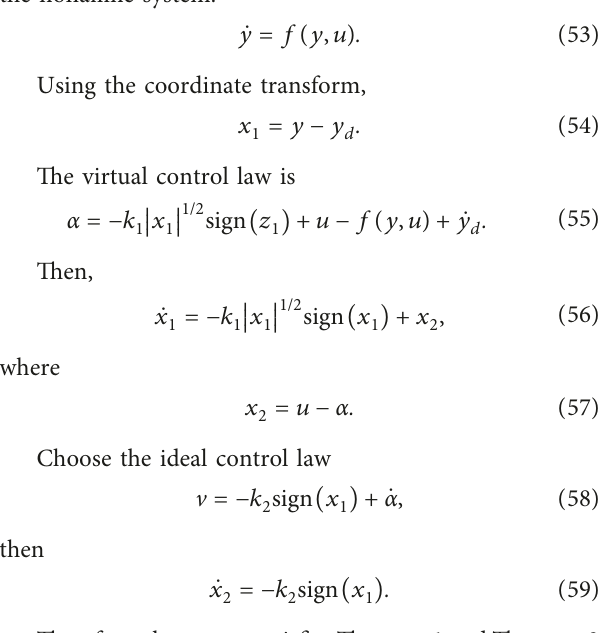
+ t � 10 . 0509 in 0 00